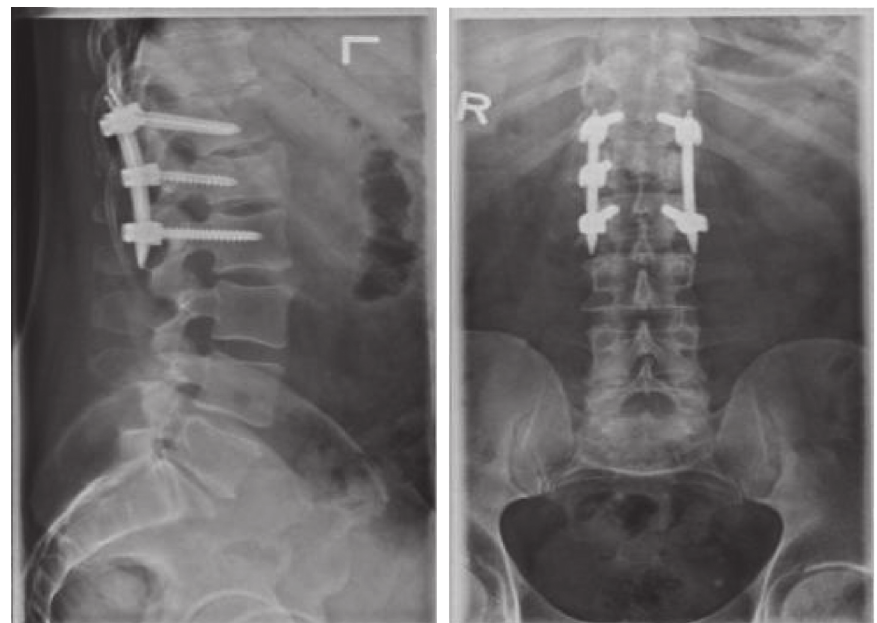
Figure 2: Lateral and AP X-ray of percutaneous stabilization of L1 burst fracture treated percutaneously at T12–L2 at 12-month